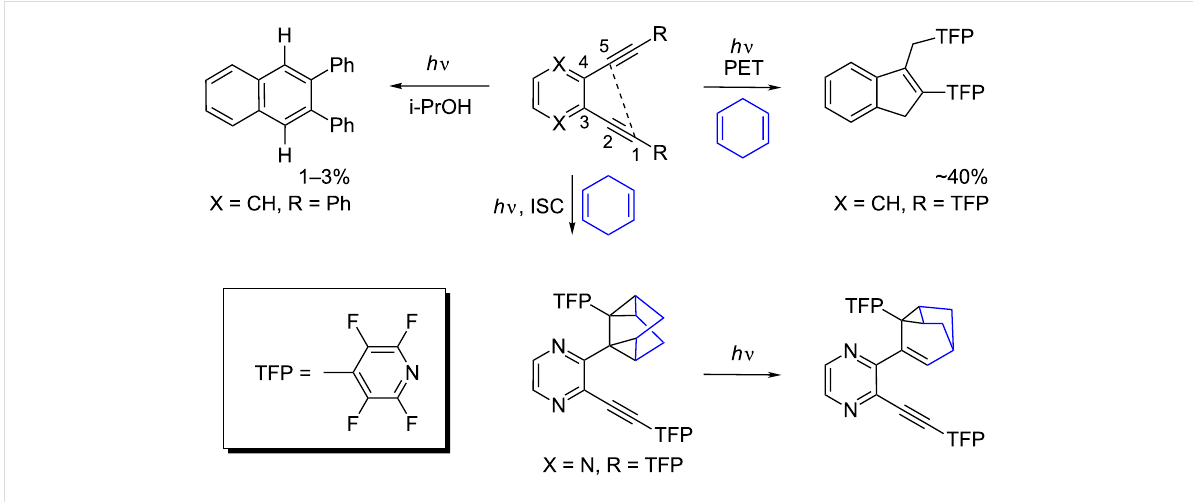
Figure 2: Alternative pathways of enediyne photoreactivity: photo-Bergman cyclization (left), C1–C5 cyclization (right), and triplet photocycloaddition (bottom). TFP = tetrafluoropyridinyl.